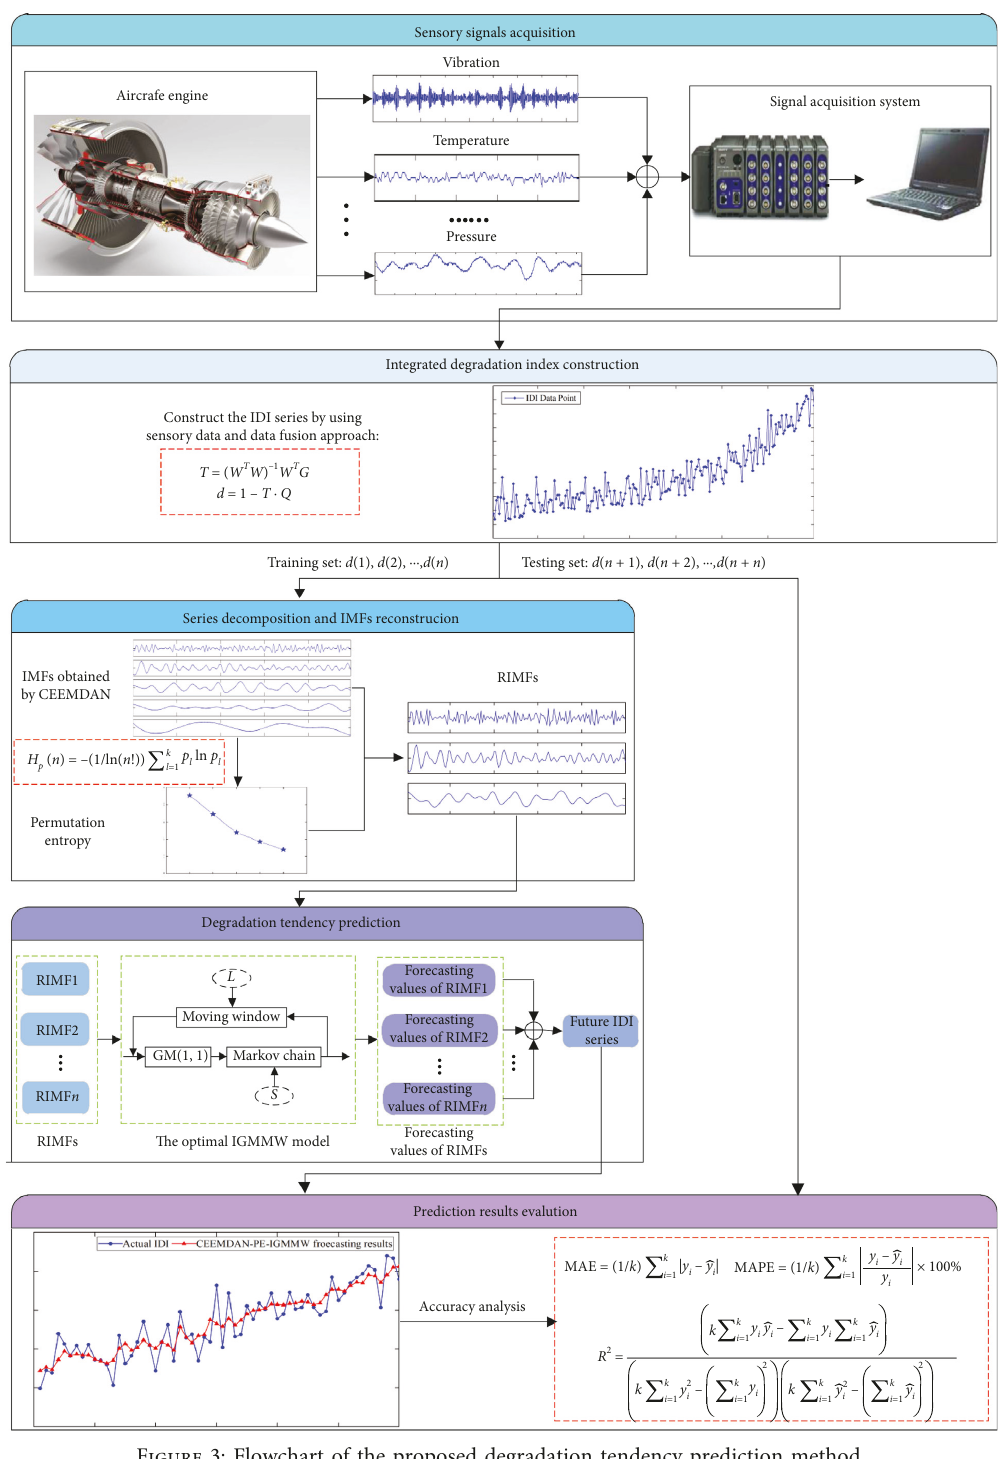
Figure 3: Flowchart of the proposed degradation tendency prediction